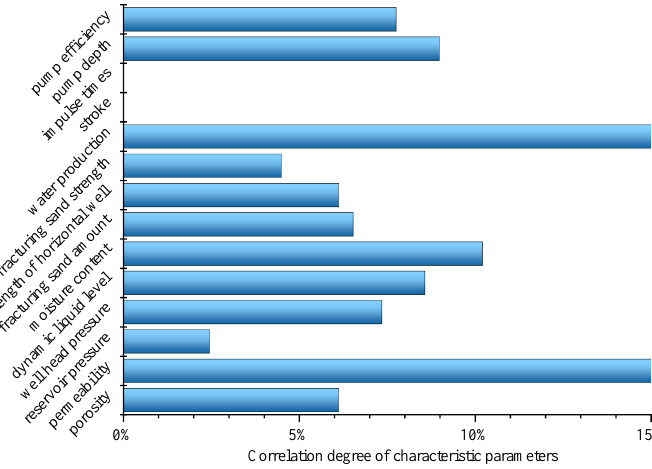
Figure 7. Histogram of correlation coefficient importance.